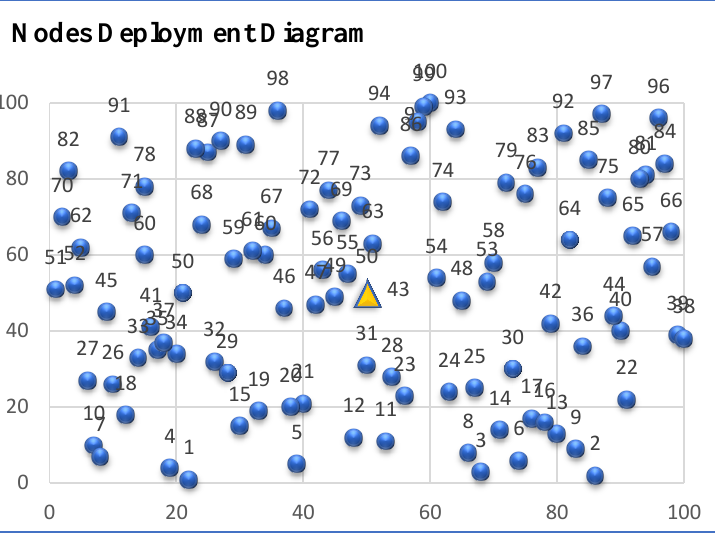
Figure 5. Distribution of network nodes. represents the BS and ● is considered as ordinary sensor nodes.